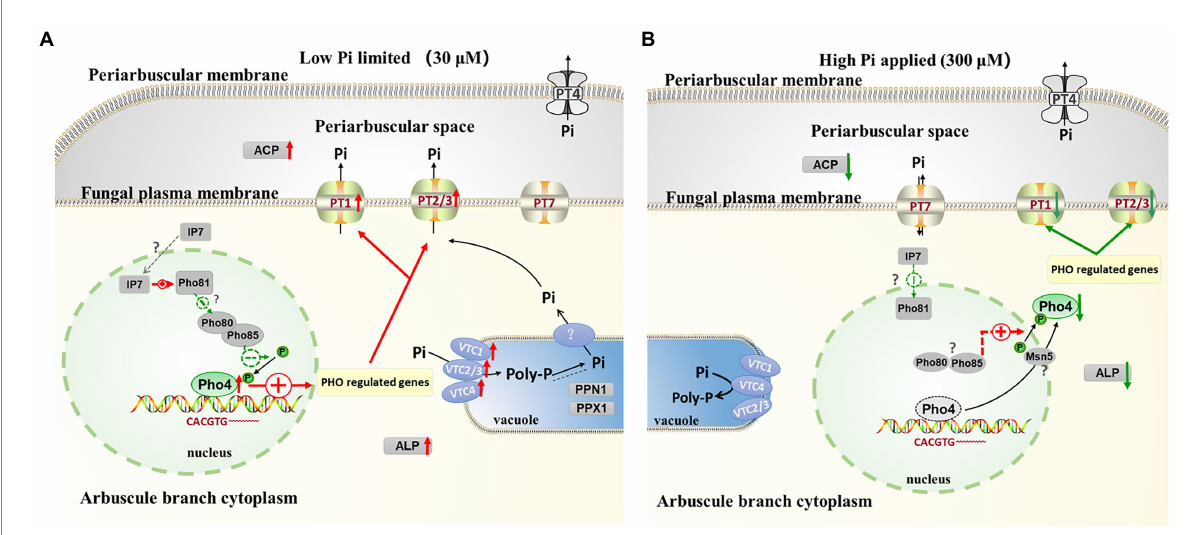
FIGURE 9 Schematic representation of the function of RiPho4 protein regulating phosphate transport and homeostasis in R. irregularis during AM symbiosis. (A) Under Pi limiting conditions, it is predicted that RiPho4 may be hypo-phosphorylated by RiPho80-RiPho85 complex (Jeffery et al., 2001), and Pho4 locates in nucleus to activate the transcription of downstream genes involved in the PHO pathway, such as PT1/2/3 , ACP , ALP , PPN1 and PPX1 . (B) Under high Pi conditions, the SPX domain-containing Pi transporter RiPT7 is responsible for Pi transport at the symbiotic interface (Xie et al., 2022), whereas the IP7 signal is predicted to be inhibited and the Pho85-Pho80 complex may phosphorylate Pho4 protein (Lee et al., 2008), which is exported from nucleus to cytoplasm, then switches off the PHO pathway. Negative and positive regulatory effects were indicated by green and red arrows, respectively. The relationships between the well-known genes and those not yet determined were shown by the solid and dashed heads, respectively. IP7, inositol heptakisphosphate; Poly-P, polyphosphate; Pi, inorganic phosphate. The green up and red down arrows next to genes indicated that transcript levels of genes were increased and decreased,